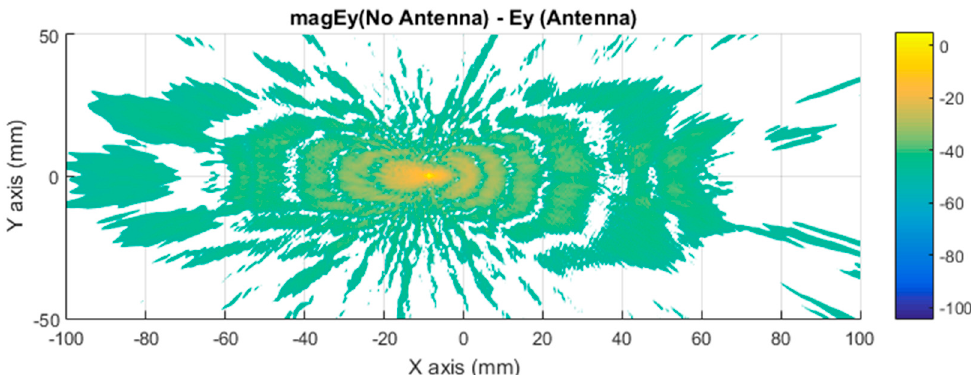
Figure 10. Distribution of near electric field difference between a vehicle with and without antenna in magnitude (in logarithmic scale) for the Y axis component, evaluated on a plane in contact with the top of the car, illuminated at 300 GHz.